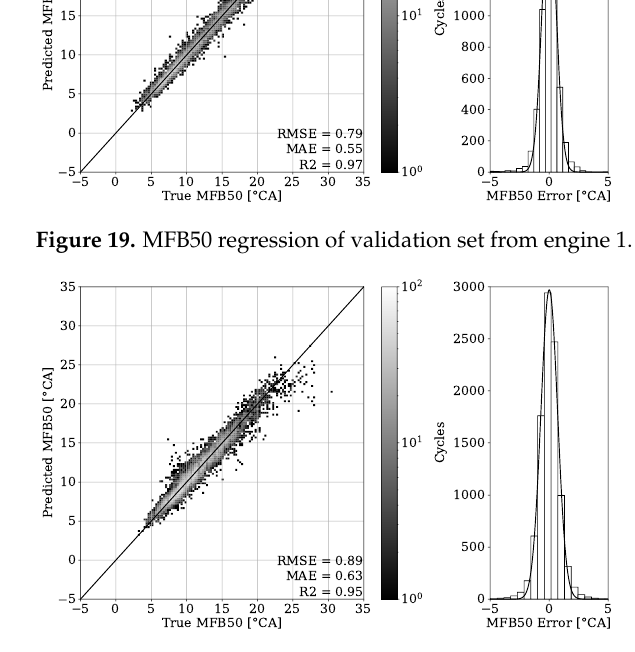
Figure 20. MFB50 regression of test set from engine